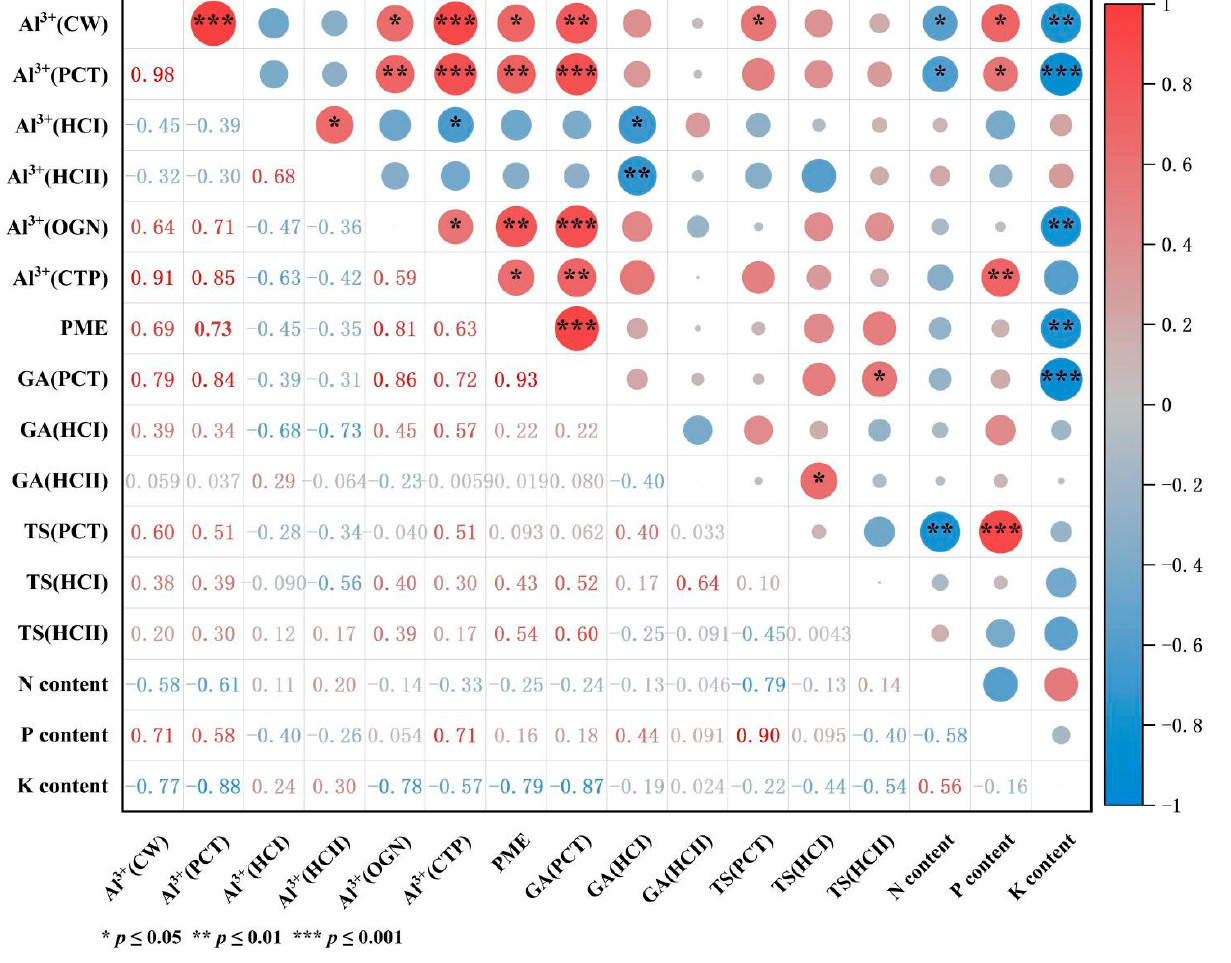
Figure 6. Interaction between Al 3+ concentration in root tip subcellular components and PME activity, and GA, TS, and N, P, and K content under Al stress. Note: data of Eucalyptus clones G4 and G9 are combined to show correlations between Al 3+ concentration and other indicators. Numbers in blocks represent correlation coefficient; 1 indicates completely positive correlation, − 1 indicates completely negative correlation, and 0 indicates no correlation. Al 3+ (CW): Al 3+ concentration of cell wall; Al 3+ (PCT): Al 3+ concentration of pectin; Al 3+ (HC I): Al 3+ concentration of hemicellulose I; Al 3+ (HC II): Al 3+ concentration of hemicellulose II; Al 3+ (OGN): Al 3+ concentration of organelle; Al 3+ (CTP): Al 3+ concentration of cytoplasm. PME, pectin methylesterase; TS, total sugar content; N, nitrogen; P, phosphorus; K, potassium.